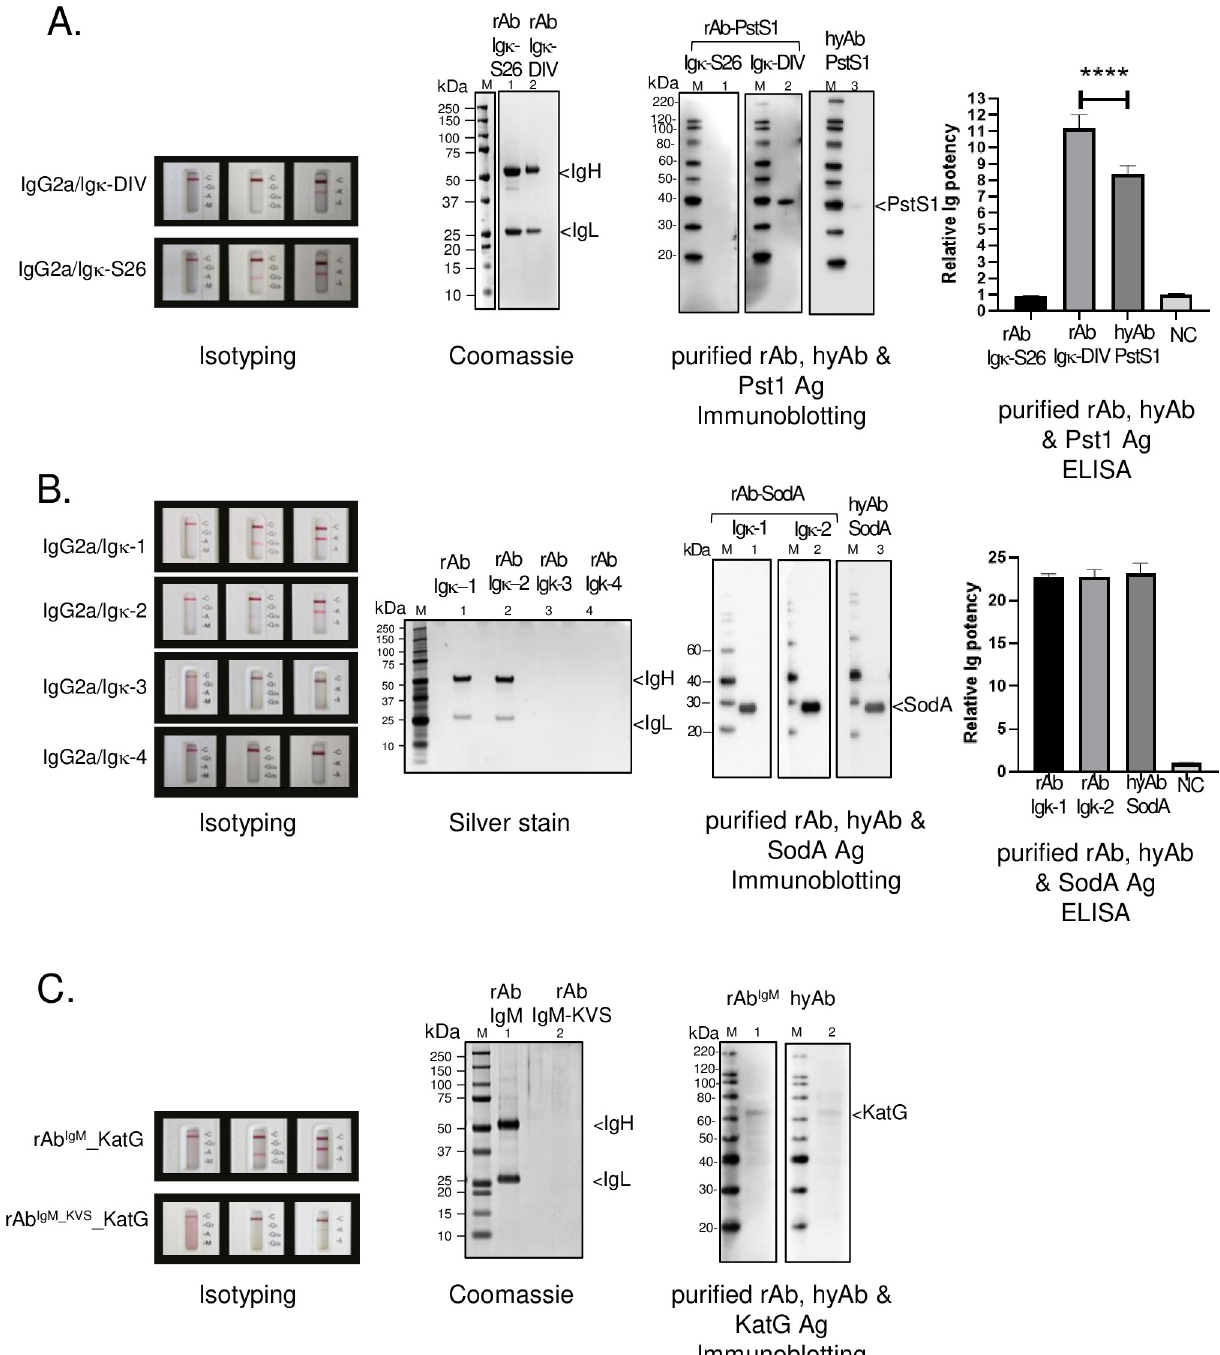
Fig 4. IgV sequence validation of PstS1 NRC-2410 , SodA NRC-13810 , and KatG NRC-49680 hybridomas. The correct IgV sequences of PstS1 NRC-2410 ( A ), SodA NRC-13810 ( B ) and KatG NRC-49680 ( C ) were identified from multiple IgV H and IgV L sequences ( S3 and S4 Tables ). Each heavy and light chain combination of the isotype-switched IgG2a and Ig κ constructs was separately co-expressed in 293 F cells by transient transfection. The presence of an assembled, secreted rAb can be detected in the culture supernatant on Day-6 post-transfection using a mouse Ig Isotype kit (Isotyping label). Some combinations yield an undetectable Ig in the cellular supernatant. The cellular supernatant of each combination was collected and purified by protein A column chromatography. The Ig-equivalent elution fractions were pooled and concentrated. Coomassie or silver staining shows the purity of the rAbs. The Ag-Ab binding potential of each IgV H /IgV L pair was compared to that of the corresponding hyAb. Equivalent amounts of either the rAb or hyAb were kept in immunoblot and ELISA assays to ensure equitable comparison. Immunoblot assays detected recognition of their cognate purified antigen